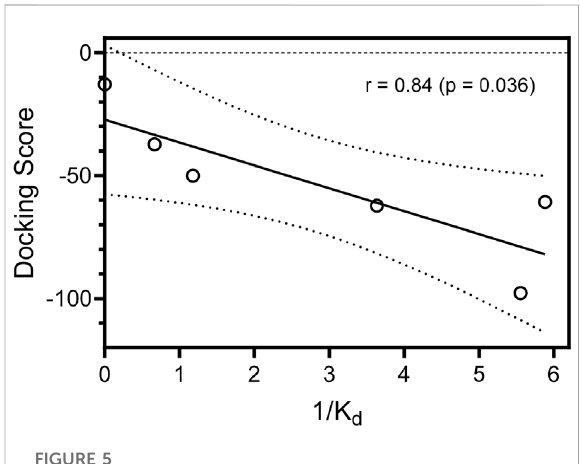
FIGURE 5 Correlation of docking scores for the best docking poses of the compounds in JNK3 and binding af fi nities (K d ) with JNK3. Binding af fi nities are represented as inverse (1/K d ) values. Dashed lines indicate area of the 95% con fi dence